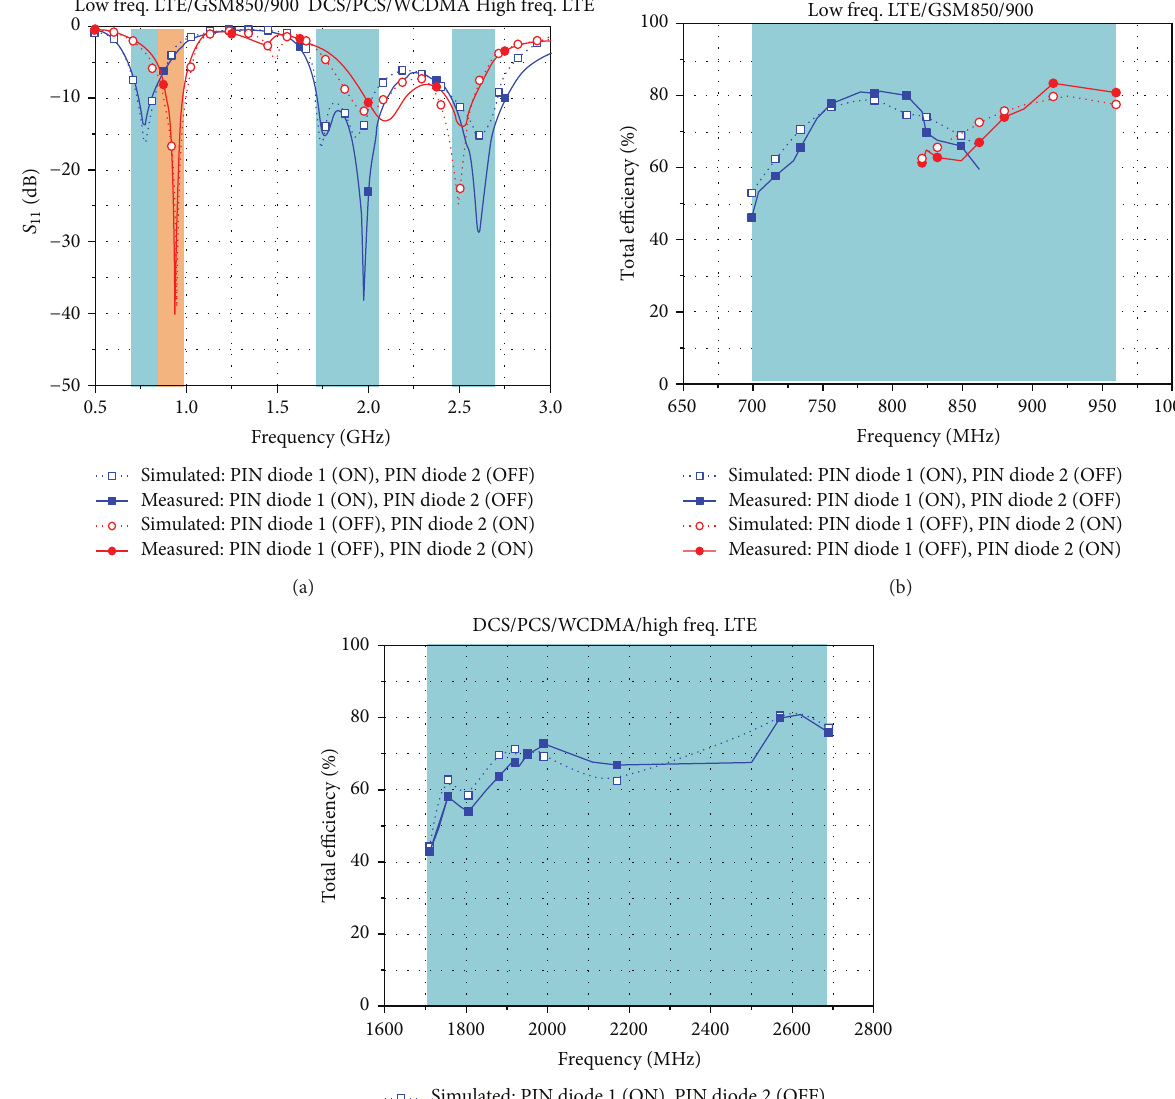
Figure 13: Simulated and measured results of the proposed antenna: (a) 𝑆 11 , (b) total efficiency at the low frequency band, and (c) total efficiency at the high frequency